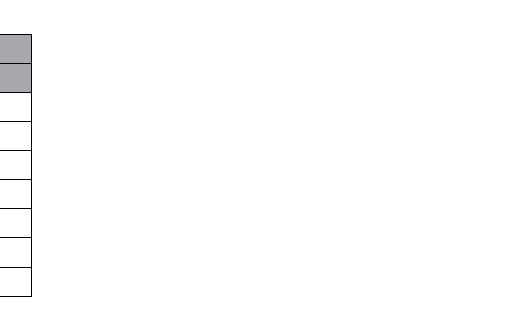
Table 2. Composition of the samples from EDX